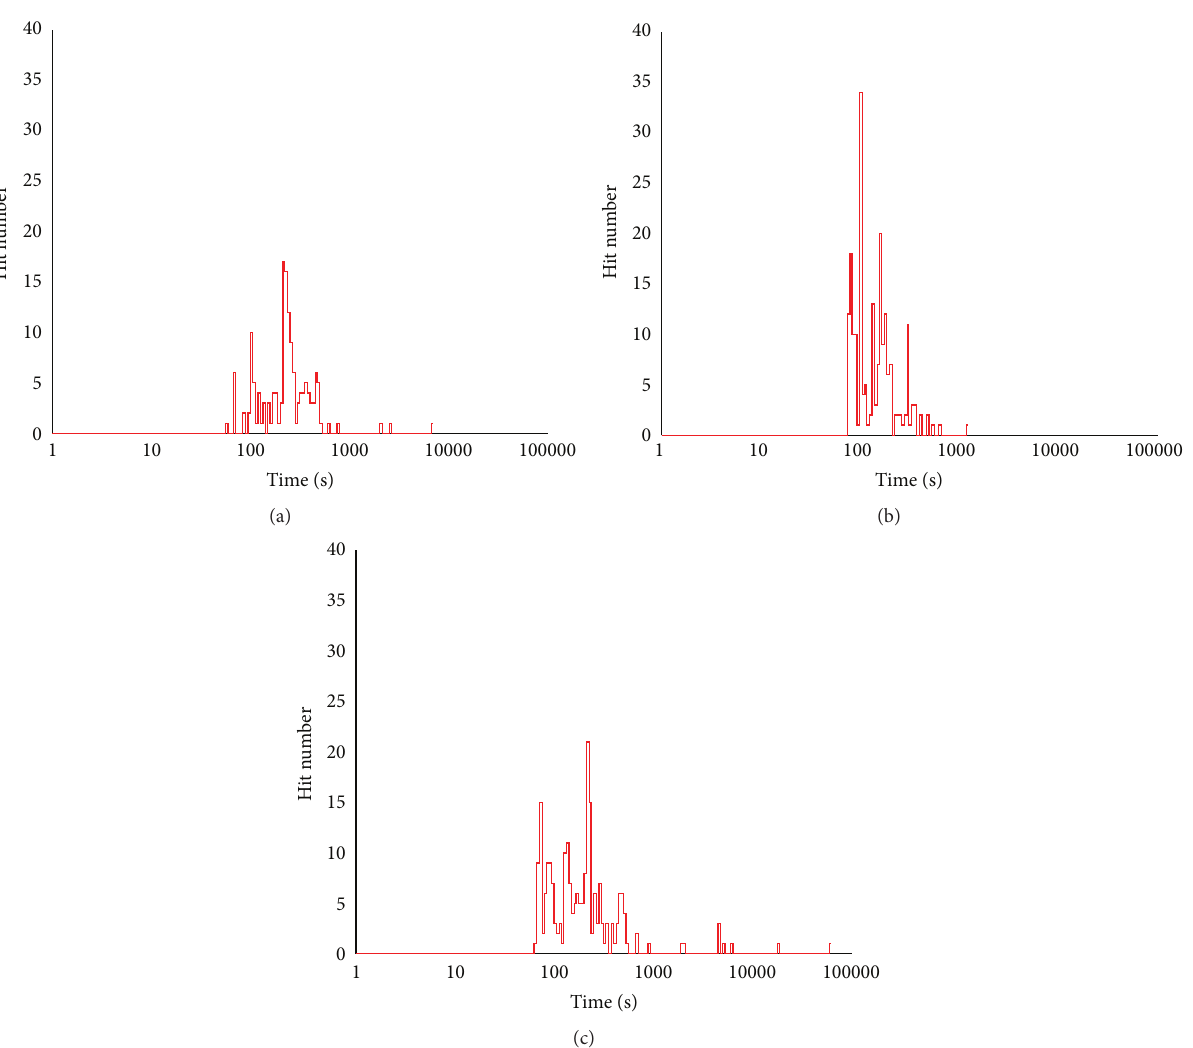
Figure 7: Change of AE hit number with the tensile loading time for fiber breakage in three specimens: (a) specimen of number 1; (b) specimen of number 2; (c) specimen of number